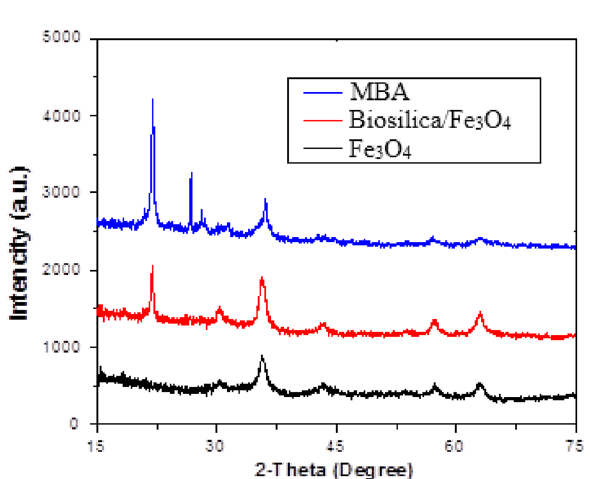
Figure 3. The XRD pattern of Fe 3 O 4 , biosilica/Fe 3 O 4 and MBA